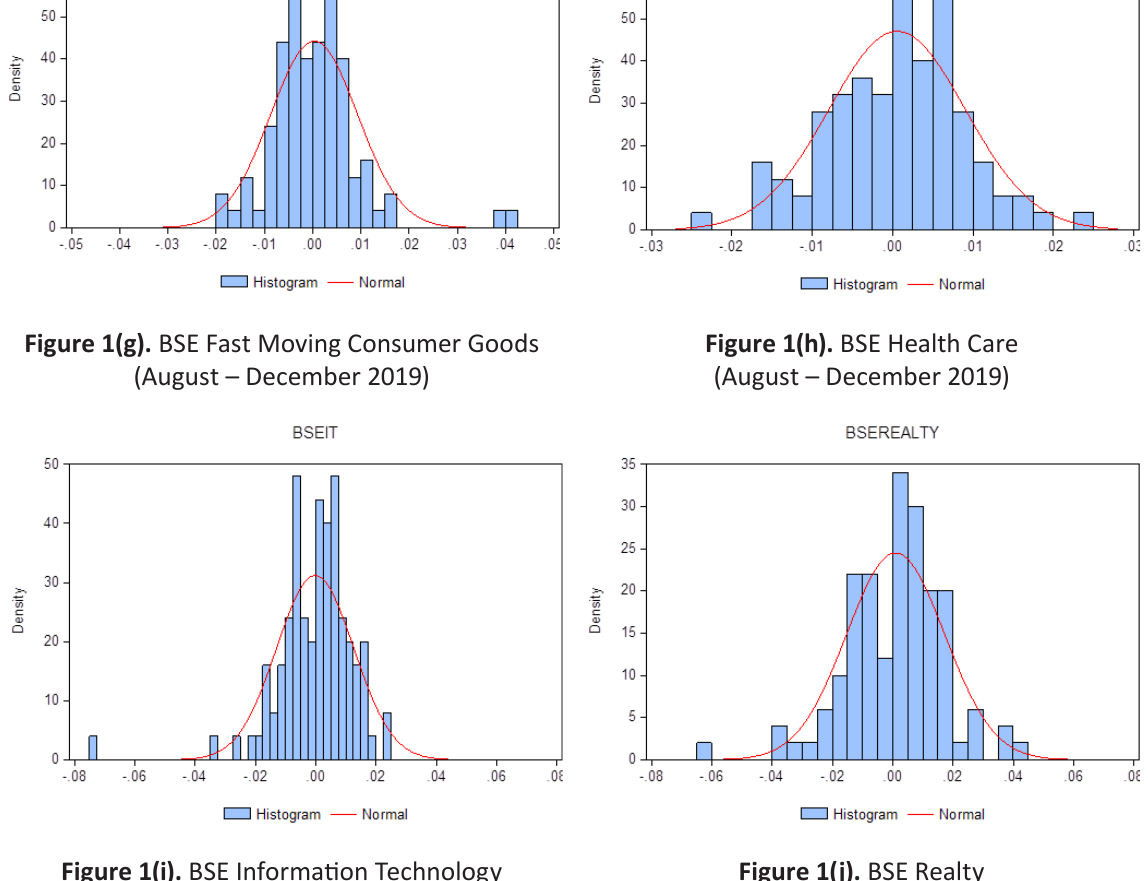
Figure 1 (cont.). Frequency and normal distribution of stock returns during the crisis period and the pre-crisis